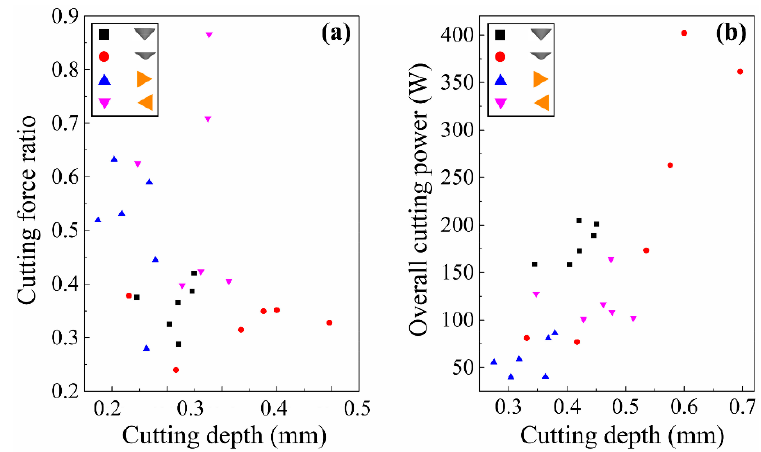
Figure 14. Analysis of cutting efficiency and energy consumption ( λ = 0 ° ): ( a ) experimental cutting force ratios for single grits and ( b ) overall cutting power for single grits.